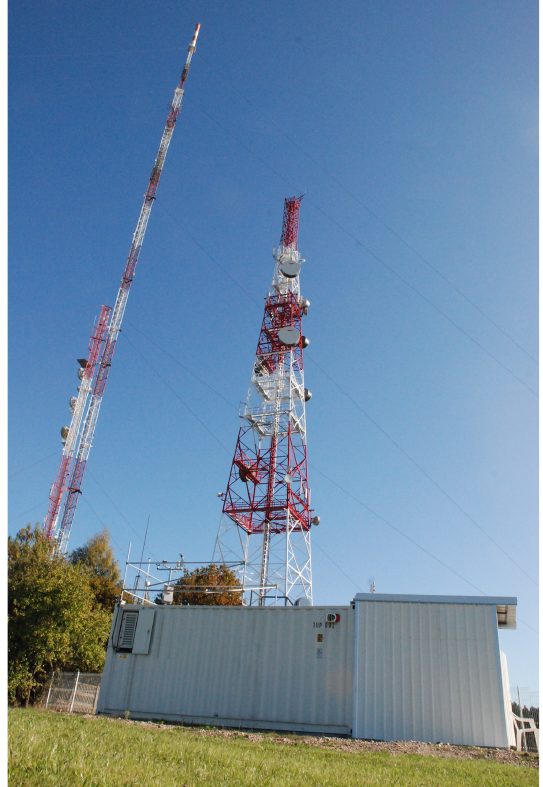
Fig. 1. The Białystok site. In the foreground the FTS observatory with an attached shelter can be seen. In the background the tall tower is